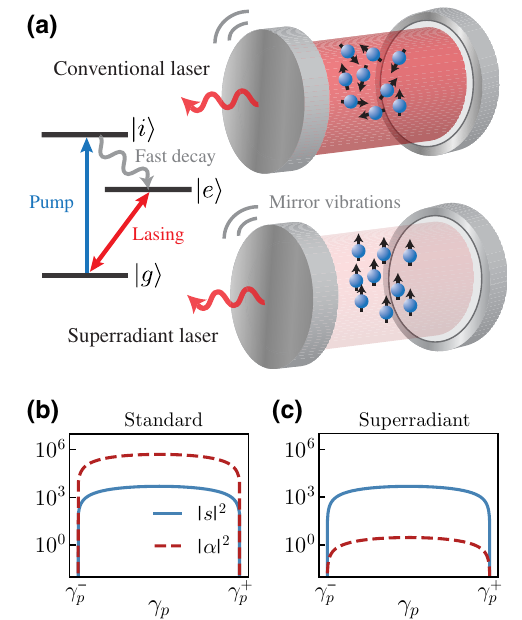
FIG. 13. (a) A gain medium is represented by an incoherently pumped (via intermediate state | i (cid:2) ) three-level system with lasing occurring on the | e (cid:2) - | g (cid:2) transition. In a standard laser, stimulated emission produces a large intracavity field amplitude exhibiting coherence past threshold. In a superradiant laser, the intracavity field amplitude is instead kept small and coherence is stored in the collective atomic dipole thus protecting the laser linewidth from thermal effects. (b) Behavior of intracavity photon number | α | 2 and coherence | s | 2 in the standard, good cavity regime ( κ = 0.1 g ) and (c) in the superradiant, bad cavity regime ( κ = 40 g ). Other parameters are γ = 10 − 2 g and N = 200. Notice that the ≈ N g 2 /κ is very different in both upper threshold γ + p